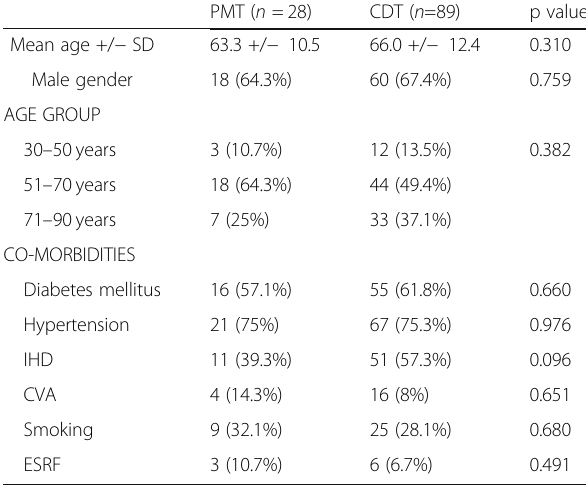
Table 3 Results